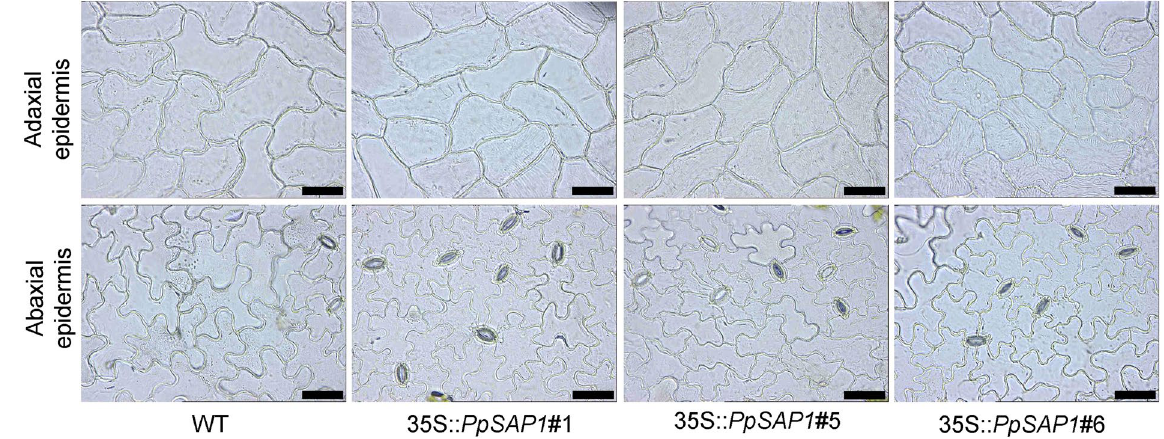
Figure 8. Microscopic photographs of epidermic cells in PpSAP1 overexpressing lines. The adaxial and abaxial epidermis of wild type (WT) and 35S:: PpSAP1 lines #1, #5 and #6 is shown; scale bar, 50 μ m.